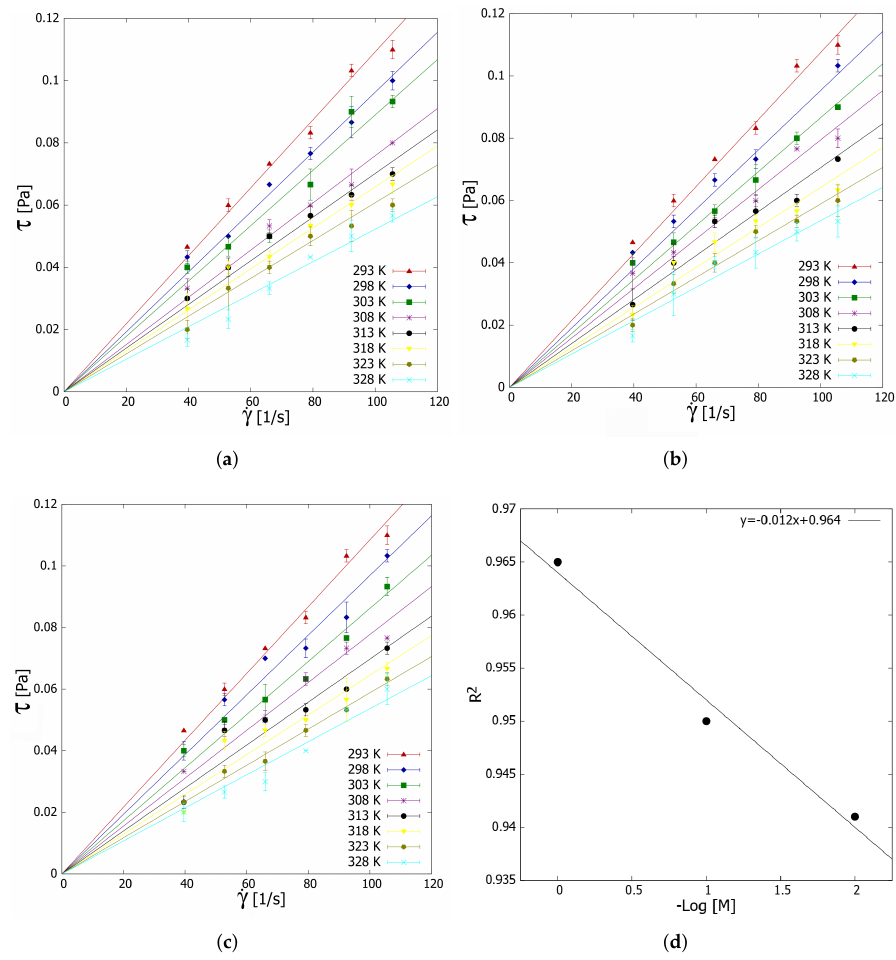
Figure 5. Rheological behavior of graphene nanofluids decorated with ( a ) 1% moles of silver, ( b ) 0.1% moles of Ag, and ( c ) 0.01% moles of silver. ( d ) The correlation coefficient of the Newtonian behavior of the nanofluids with respect to the Ag decoration degree. The error bars correspond to the measurements’ standard